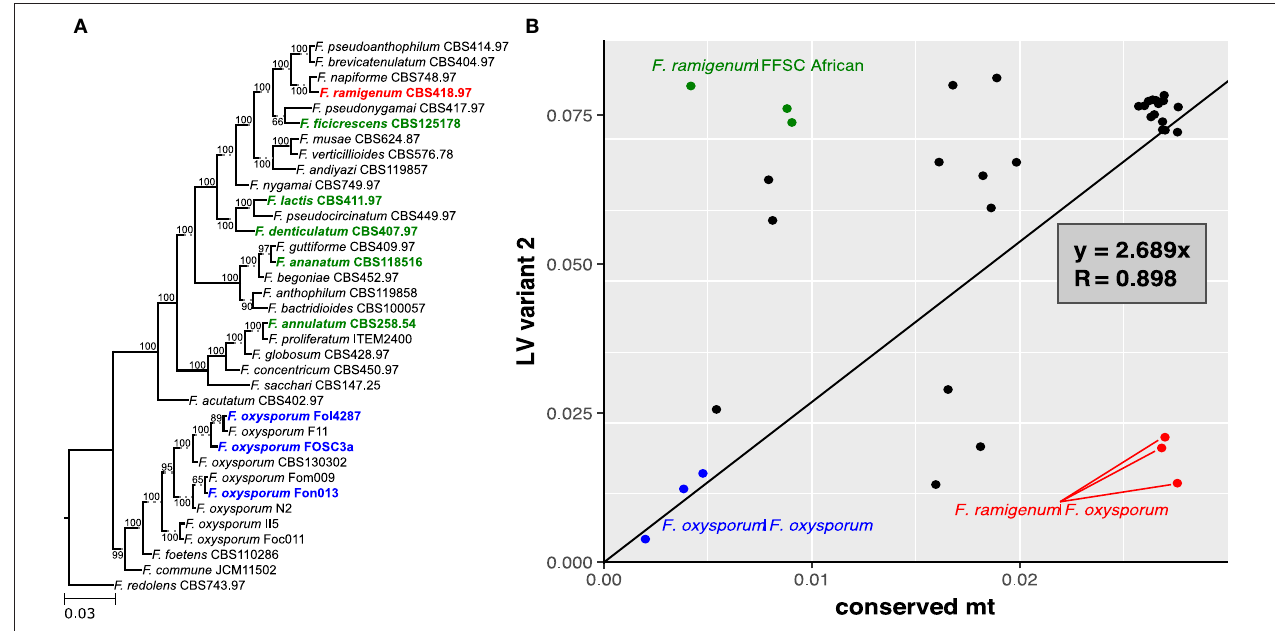
FIGURE 6 | LV region of F. ramigenum is most similar to that of F. oxysporum . (A) Species tree with bootstrap support, strains with variant 2 of the LV region are shown in boldface. (B) The plot of genetic distance between strains based on variant 2 of LV-region against conserved mt region with trend line. Function of the trend line and R are shown on the plot. FFSC vs. F. ramigenum are shown in green, while FOSC vs. F. ramigenum is shown in red. The three FOSC comparisons are shown in